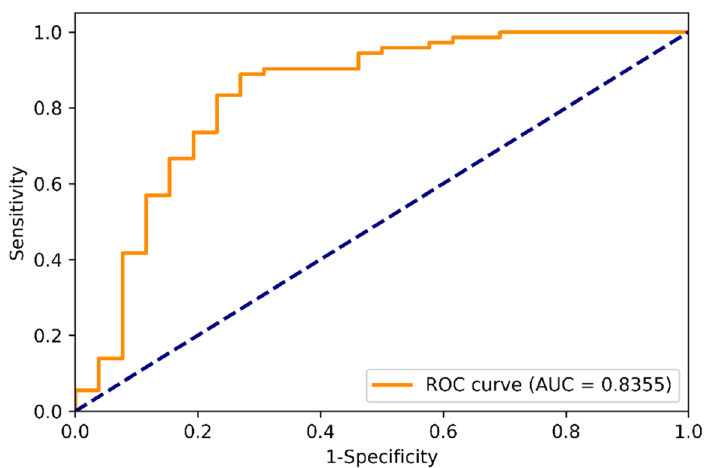
Figure 2. ROC curve in CFPs-based model. The area under curve (AUC) in this EfficientNet model by CFPs was 83.55%.